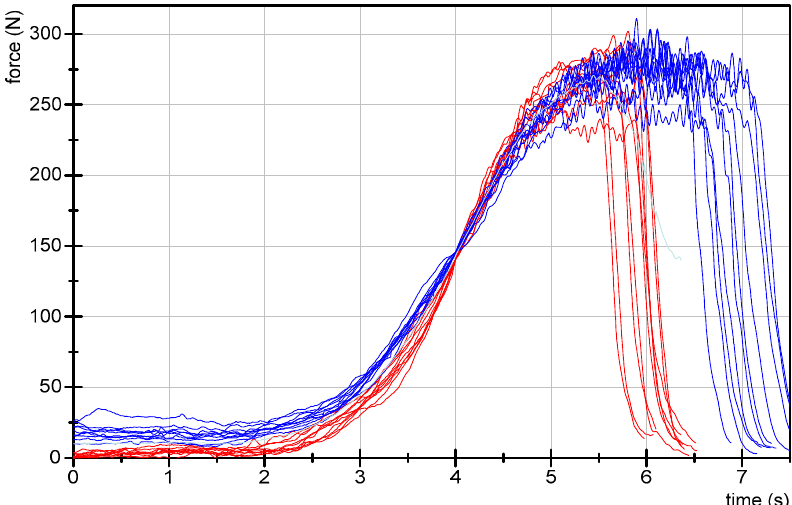
Figure 14. Ten repeated force curves of tester 1 (female, red) and tester 2 (male, blue) against a stable resistance in the MMT setting of the hip flexors with fixed leg (filtered with Butterworth, cut-off frequency 20 Hz, filter degree 5). The grey curve illustrates the average curve of all 20 trials, which is suggested as standardized force profile.